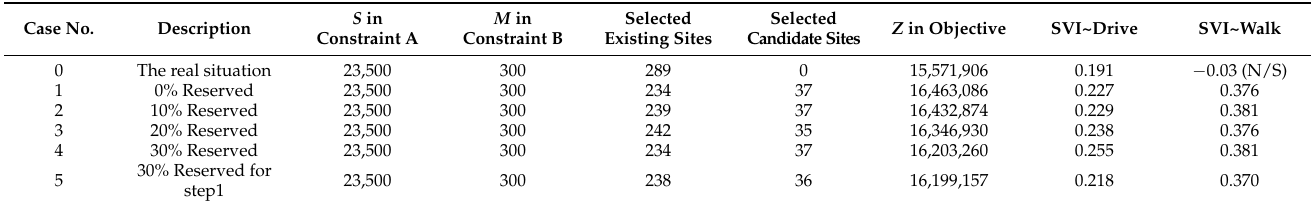
Table 1. Model results with different amounts of reserved